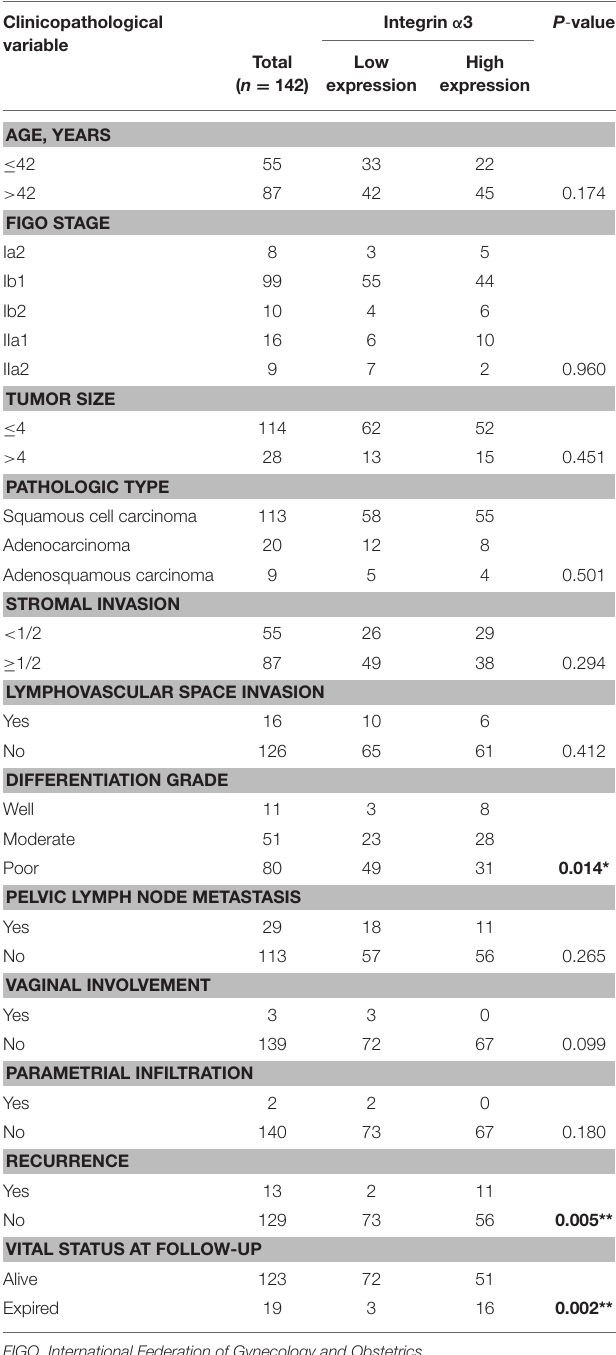
FIGO, International Federation of Gynecology and Obstetrics. * P < 0.05. ** P < 0.01. Bold values represent p <